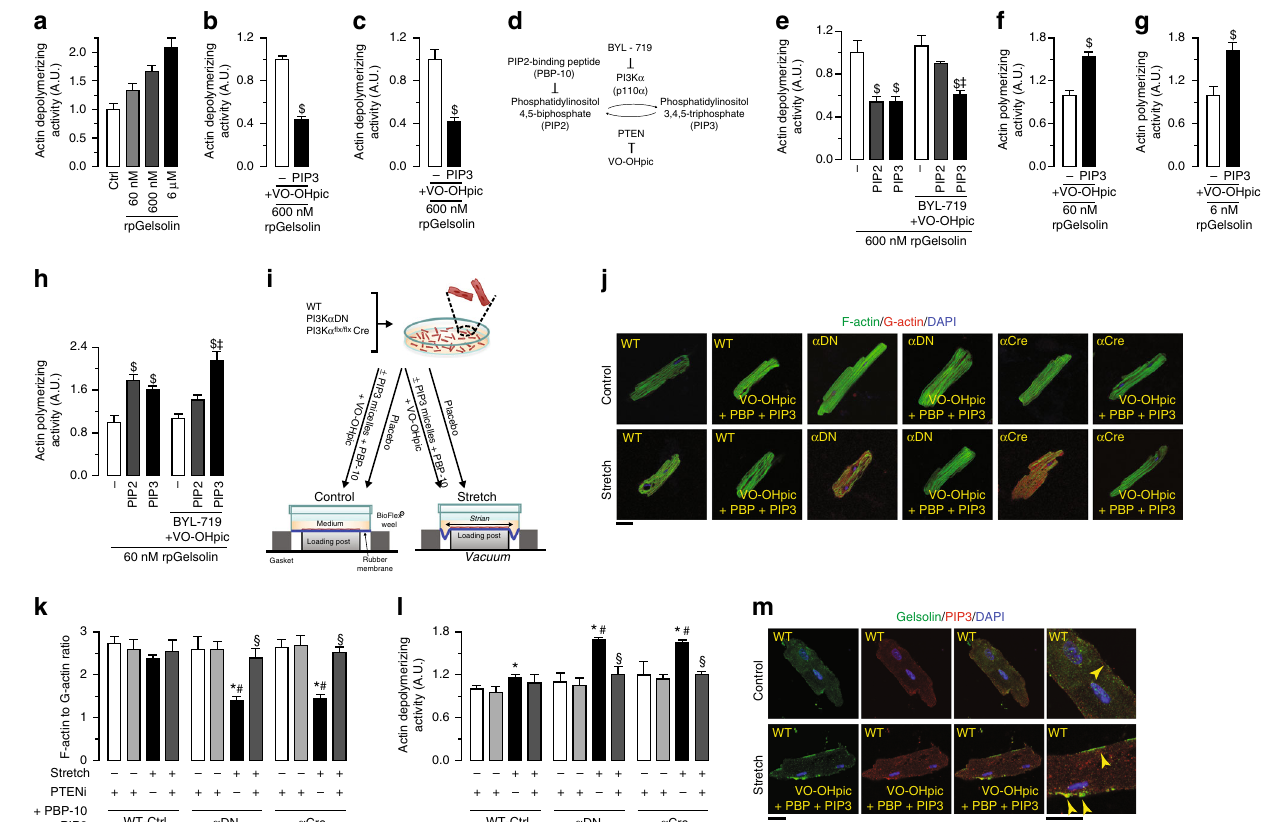
Fig. 4 PI3K α -generated PIP3 is a major negative regulator of gelsolin activity. a Concentration-dependent effect of rpGSN in actin-depolymerization assay. b , c Inhibition of actin-depolymerizing activity of 600 nM rpGSN ( b ) and 60 nM rhGSN ( c ) by PIP3 in presence of VO-OHpic. d A schematic showing the interconversion pathway of PIP2 and PIP3 by p110 α and PTEN. e PIP2-mediated inhibition of exogenous gelsolin actin-depolymerizing activity in GSNKO heart tissue homogenate is partially blocked by BYL-719 and VO-OHpic, suggesting that the conversion to PIP3 is necessary for PIP2-mediated inhibition of gelsolin activity in ex vivo actin-depolymerization assay. f , g Actin polymerization assay showing inhibition of actin-capping activity of rpGSN ( f ) and rhGSN ( g ) by PIP3 in presence of VO-OHpic. h PIP2-mediated inhibition of exogenous gelsolin actin-capping activity in GSNKO heart tissue homogenate is partially blocked by BYL-719 and VO-OHpic, suggesting that the conversion to PIP3 is necessary for the PIP2-mediated inhibition of gelsolin actin-capping activity in ex vivo actin polymerization assay. i A schematic showing the experimental plan for isolated cardiomyocyte stretching in the absence or presence of the PIP3 micelles. j – l Representative images of F- and G-actin staining ( j ), F- to G-actin ratio ( k ), and actin-depolymerizing activity ( l ) showing increased actin depolymerization in the p110 α transgenic cardiomyocytes subjected to cyclical stretch for 24 h. Addition of PIP3 micelles in presence of PBP-10 and VO-OHpic attenuated the increased actin-depolymerizing activity in stretched p110 α transgenic cardiomyocytes. m Representative gelsolin and PIP3 IF staining images showing increased PIP3 levels in PIP3 micelles-treated cells. Arrows indicate spatial colocalization of gelsolin and PIP3. Data represent means ± s.e.m. $ P < 0.05 compared with respective controls, ‡ P < 0.05 compared with PIP2 + BYL-719 + VO-OHpic group, * P < 0.05 compared with nonstretch group, # P < 0.05 compared with WT-Ctrl — Stretch group, § P < 0.05 compared with respective Stretch group as determined by unpaired two-tailed Student ’ s t test ( b , c , f , g ) and one-way ANOVA analysis ( e , h , k , l ). Biological replicates: n = 6 ( a – c , f – h , j – m ) and n = 9 ( e ). For in vitro experiments, each biological replicate was mean of technical replicates ( j – m ); only biological replicates are plotted and used for statistics. Scale bars show 25 µ m ( j , m